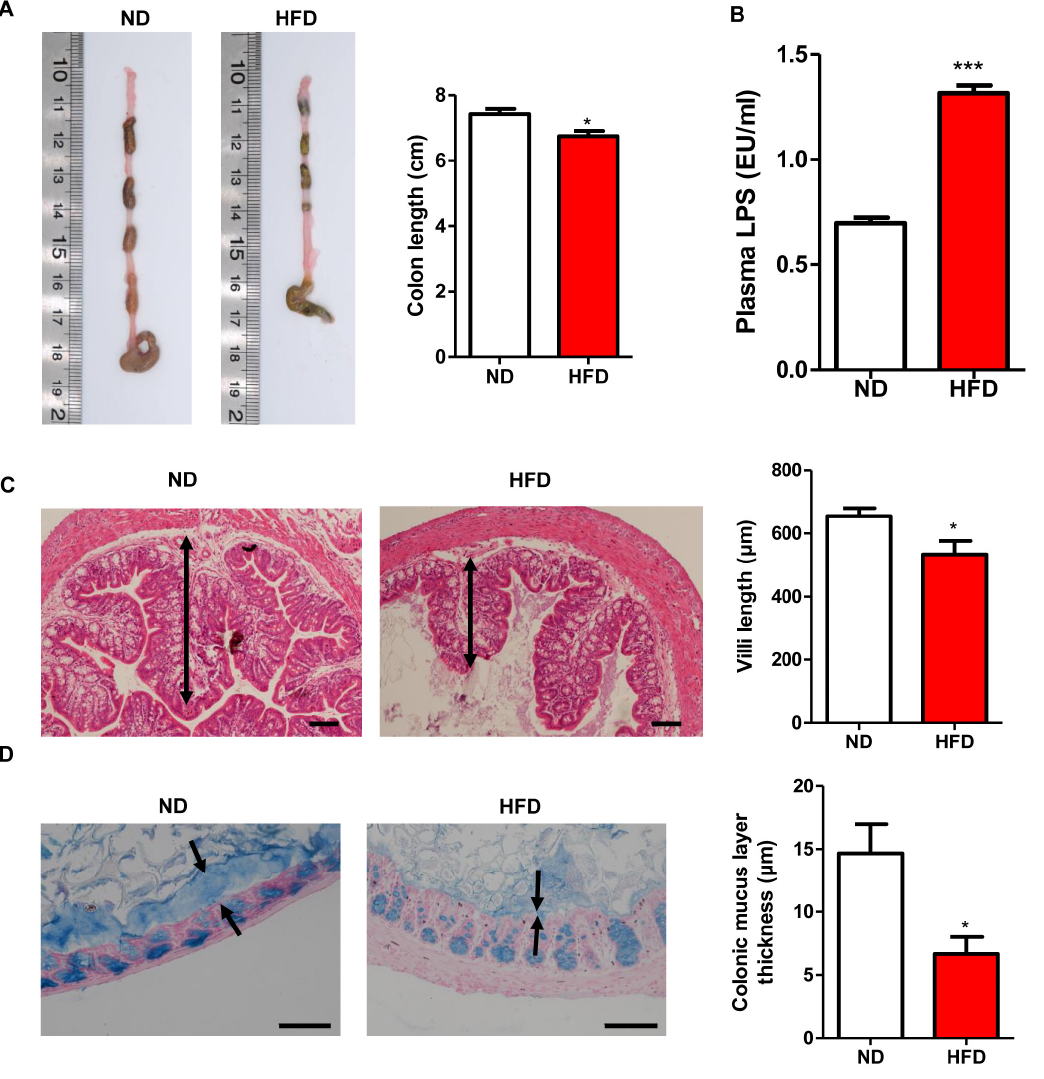
Figure 7. Effect of long-term HFD consumption on gut barrier integrity damage in mice. Colon length in ND and HFD fed mice ( A ), Plasma endotoxin level ( B ), villi length in proximal colon (( C ), Arrows indicate the length of villi), thickness of mucus layer (( D ), opposing black arrows with shafts delineate the mucus layer that was measured). Values are shown as the mean ± SEM. t -test was performed. * p < 0.05; *** p < 0.001. Bar: 100 μ m.